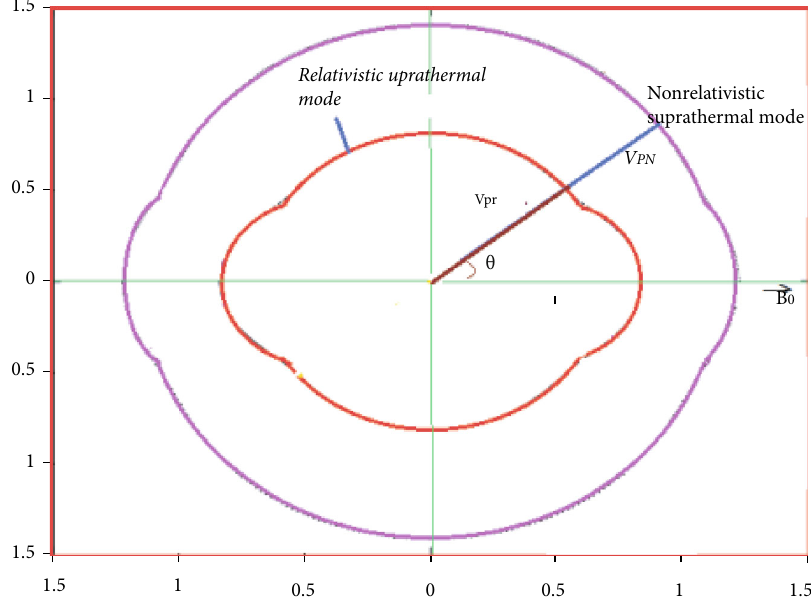
: 9, b 2 b 2 ⊥ 1 = ∥ 1 = A = 0